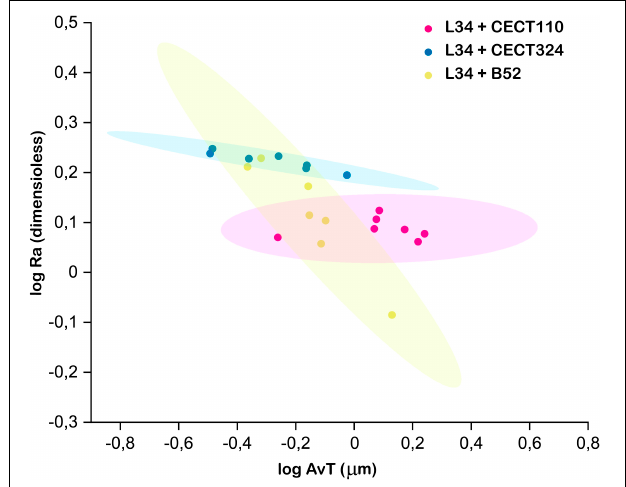
FIGURE 5 | Clustering of the three structures using log AvT and log Ra values. Each spot of the scatter plot corresponds to one z -stack. Ellipses represent the 90% confidence for each data set. Two overlapping ellipses mean that a given pair of biofilms were not statistically different at the sampling